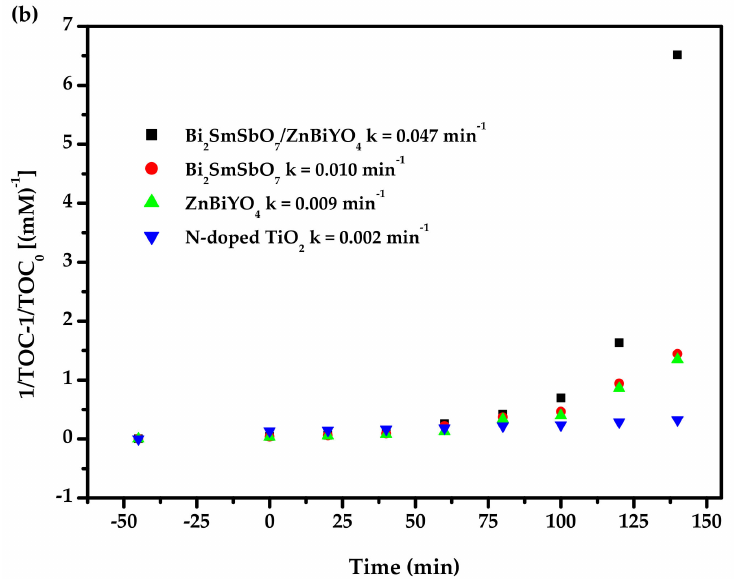
Figure 16. ( a ) Observed second-order dynamic curves for the PD of DO with Bi 2 SmSbO 7 /ZnBiYO 4 heterojunction or with Bi 2 SmSbO 7 or with ZnBiYO 4 or with N-dT as catalyst under VLI; ( b ) Achieved second-order kinetic plots for TOC during PD of DO with BZH or with Bi 2 SmSbO 7 or with ZnBiYO 4 or with N-dT as catalyst under VLI.